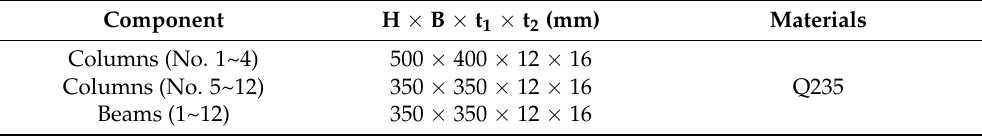
Table 1. The parameters of beams and